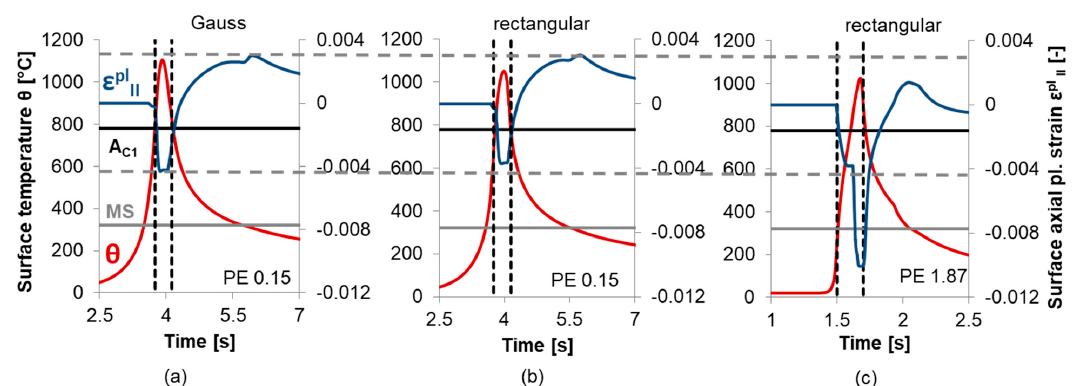
Figure 14. Temperature evolution and generated plastic strains for laser hardening with a Gaussian power profile ( a ), laser hardening with a rectangular power profile ( b ), and a grind hardening with a rectangular power profile ( c ) (Figure 13 and Table 3), black dashed lines indicate begin and end of the power impact, grey dashed lines indicated the minimal and maximal axial plastic strains in case of low Peclet number PE 0.15.